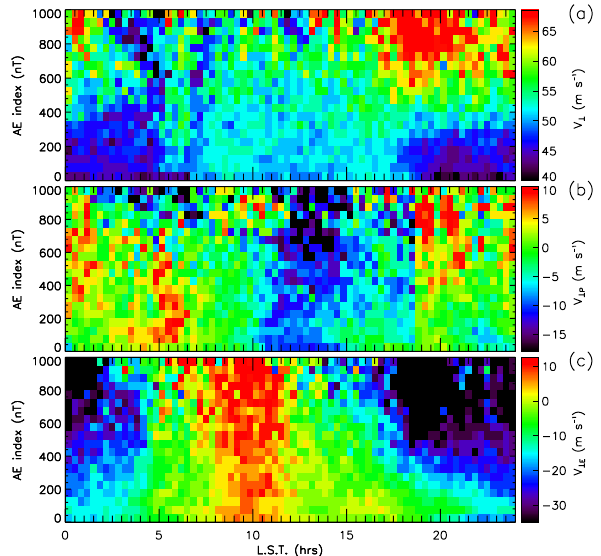
Fig. 5. Colour map showing the variation of (a) velocity magnitudes V ⊥ , (b) V ⊥ P , and (c) V ⊥ E with LST and D st index for the entire 5-year database. The velocities were averaged using bin sizes of 20min in LST and 7nT in D st